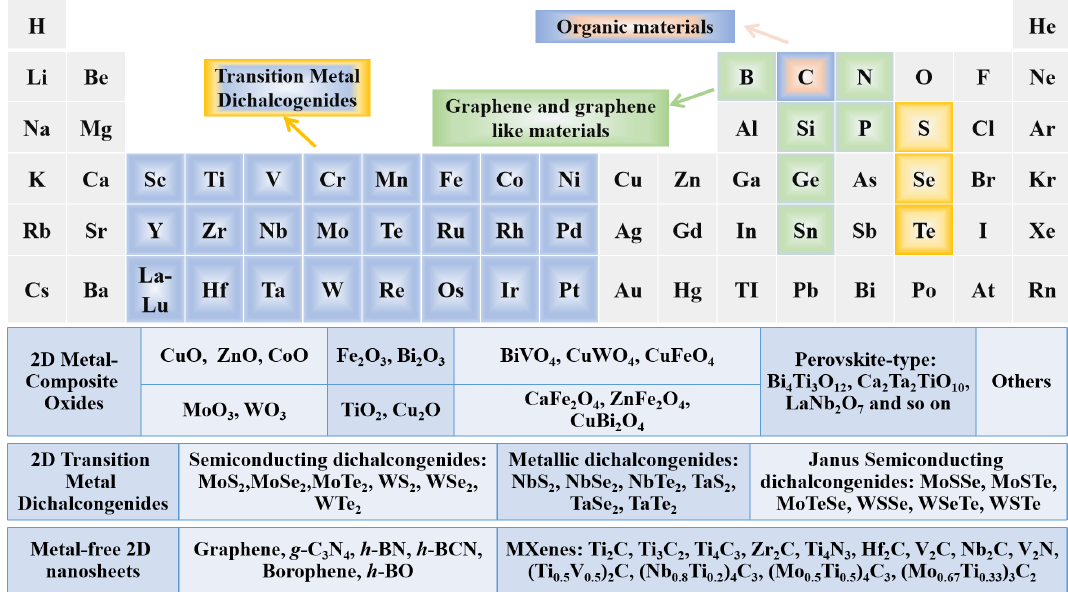
Figure 3. Periodic table with highlighted elements for typical ultrathin 2D